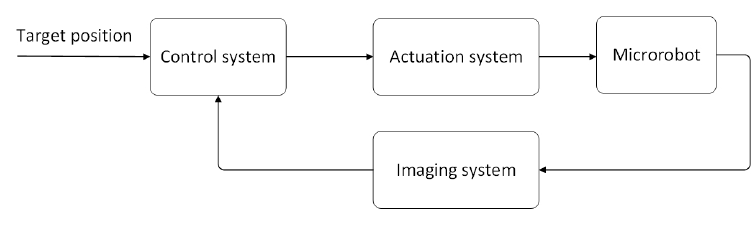
Figure 1. Block diagram of the